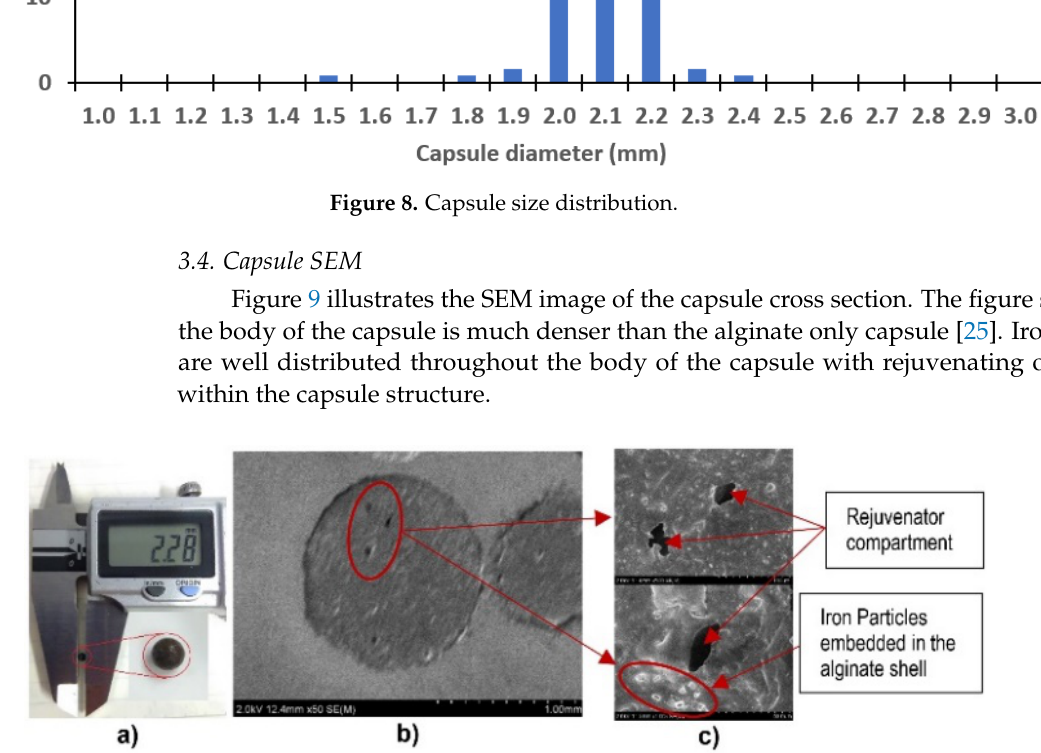
Figure 9. ( a ) Capsule image, ( b , c ) cross section of the microscopic (SEM) image of the capsule.